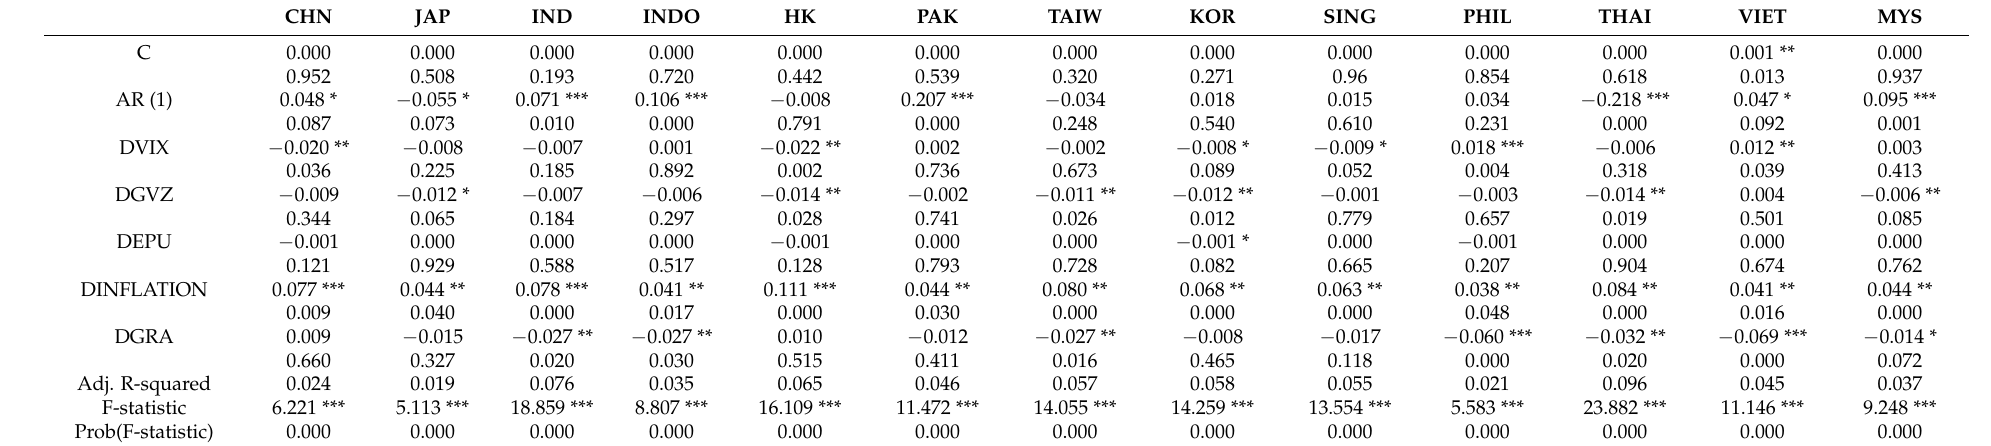
Table 6. Determinants of the hedge portfolio returns in the pre COVID-19